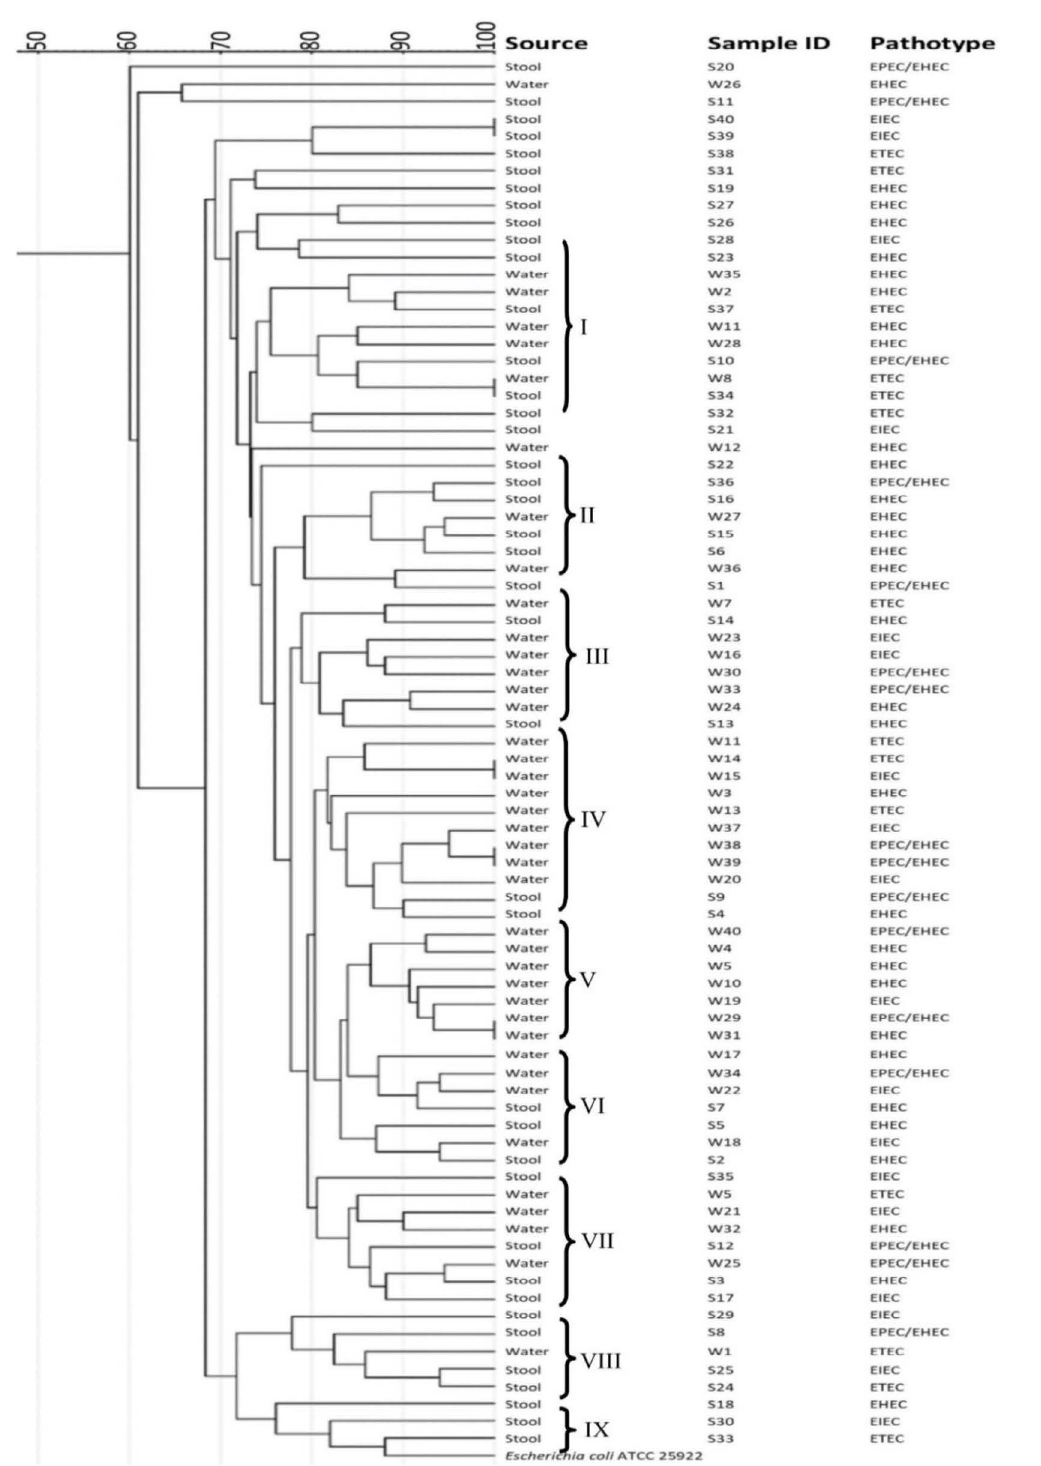
Fig. 3. Clonal relatedness of E. coli pathotypes from human and water as determined by